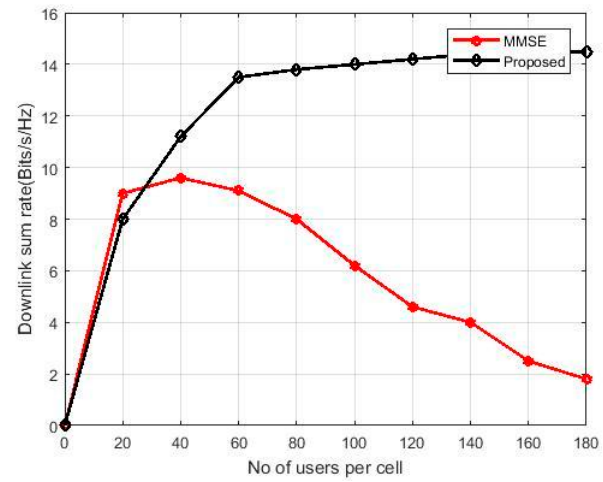
Figure 6. Performance of Downlink sum rate.